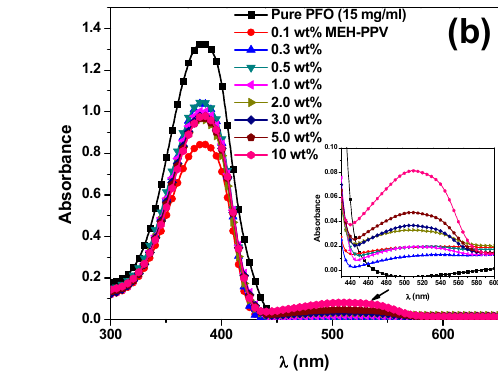
Figure 4. Absorbance of the hybrids of PFO with different weight ratios of ( a ) MDMO-PPV–DMP and ( b ) MEH-PPV. Insets are absorbance of each binary hybrid in the range of 440–600 nm.